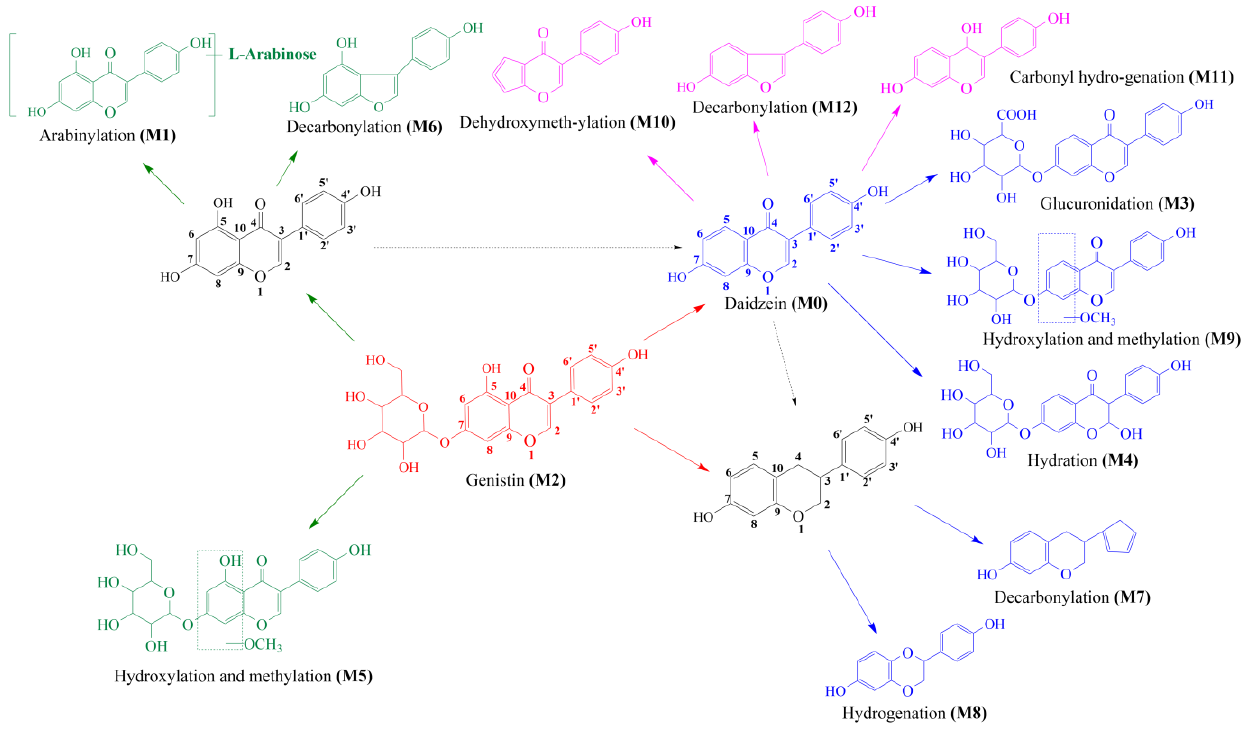
Figure 2. The proposed metabolic patterns of genistin in normal and hyperlipidemic rats. The parent nucleus of genistin was labeled with red; the common metabolites in hyperlipidemic and normal administration rats were labeled with green; metabolites in normal administration rats were labeled with blue; and metabolites in hyperlipidemic administration rats were labeled with pink.